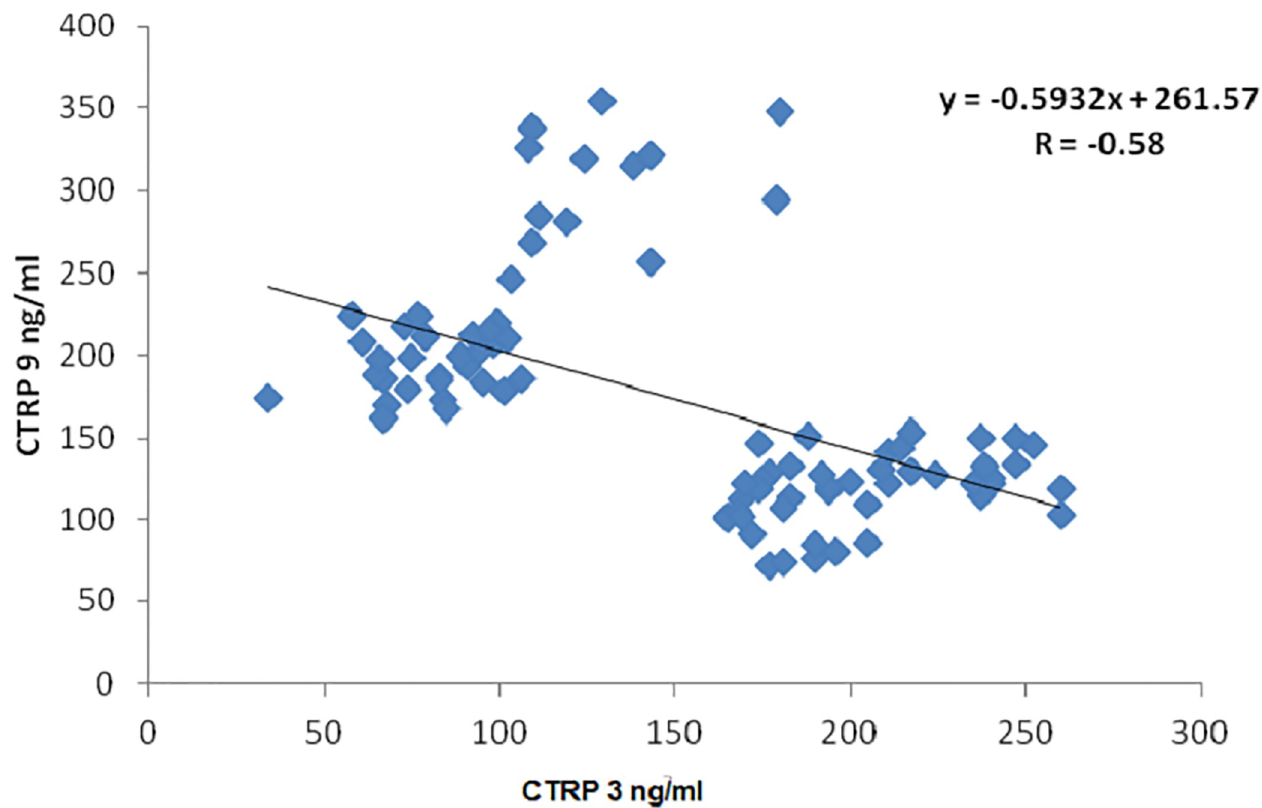
Fig 4. Correlation between CTRP9 and CTRP3. CTRP3: C1q complement/tumor necrosis factor (TNF)—related protein 3, CTRP9: C1q complement/tumor necrosis factor (TNF)—related protein 9.